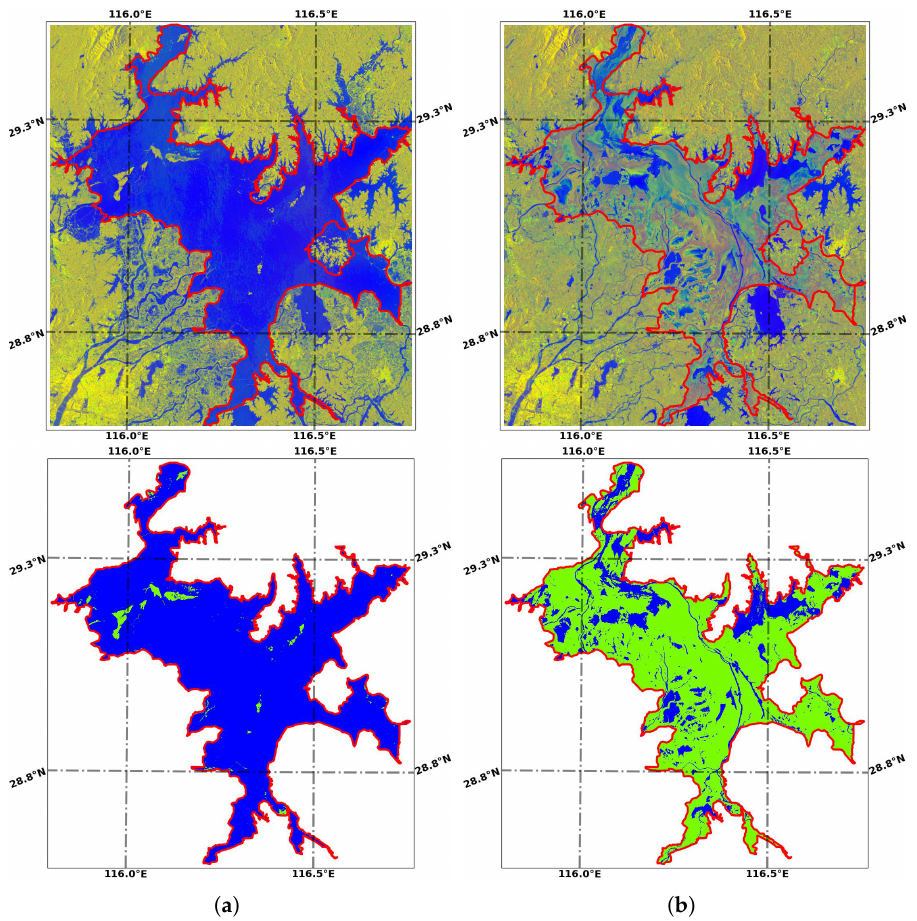
Figure 11. The maximum and minimum water area from 2014 to 2021. Blue is for water and green is for non-water. ( a ) maximum water area on 20 July 2020; ( b ) minimum water area on 4 January